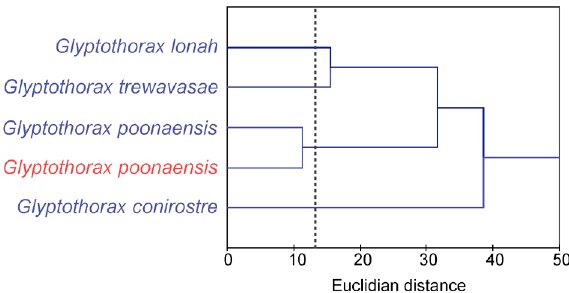
Figure 1. Comparison of morphometric data of present collection with Hora’s (1938) data. Dendrogram is plotted using Euclidian distances and Ward’s method. (Species names shown in blue are based on Hora’s (1938) data, while red corresponds to present study). Dashed line is the significance